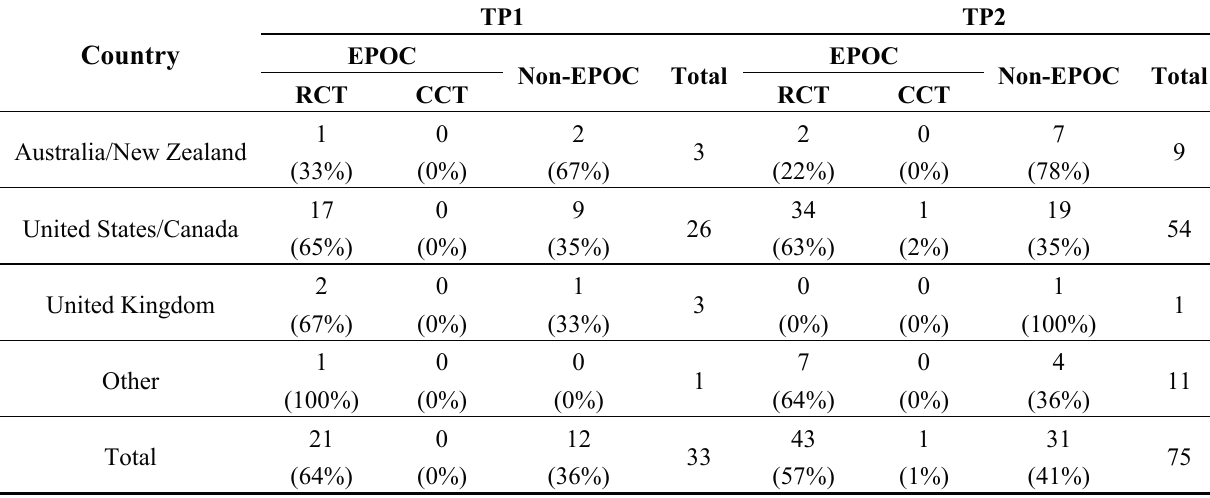
Table 3. Number of intervention studies and respective EPOC evaluation design used by country represented by number of publications and proportion (%)